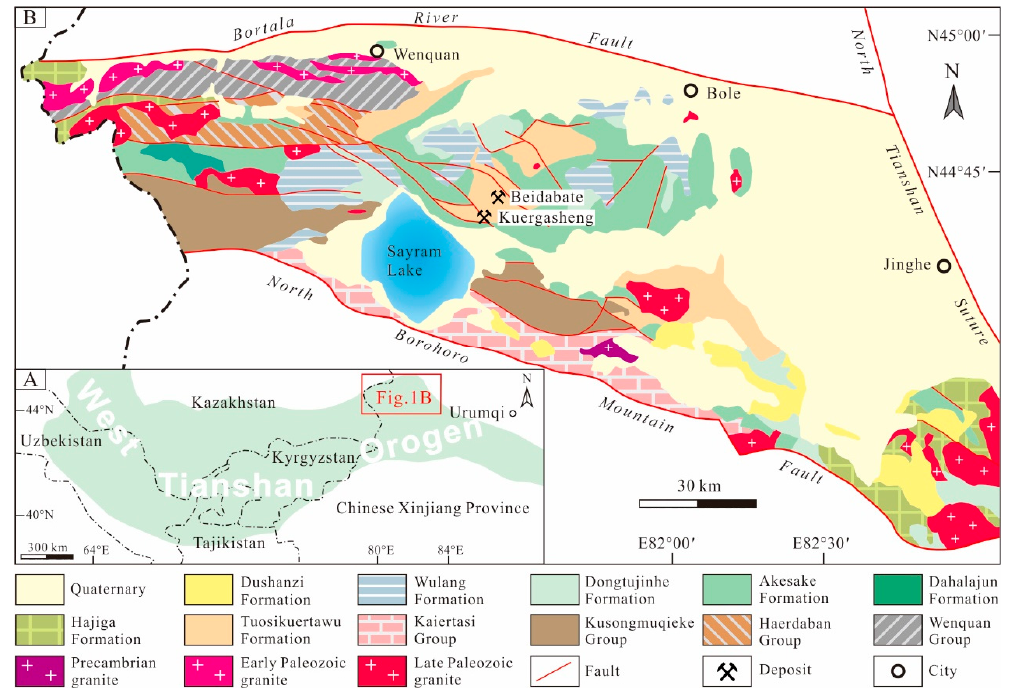
Figure 1. ( A ) Tectonic framework of the WTO (modified after Biske and Seltmann [7]); ( B ) Geological Figure1. ( A )TectonicframeworkoftheWTO(modifiedafterBiskeandSeltmann[7]); ( B )Geologicalmap map of the Sayram Lake area (modified after Xue et al. [12]). of the Sayram Lake area (modified after Xue et al.